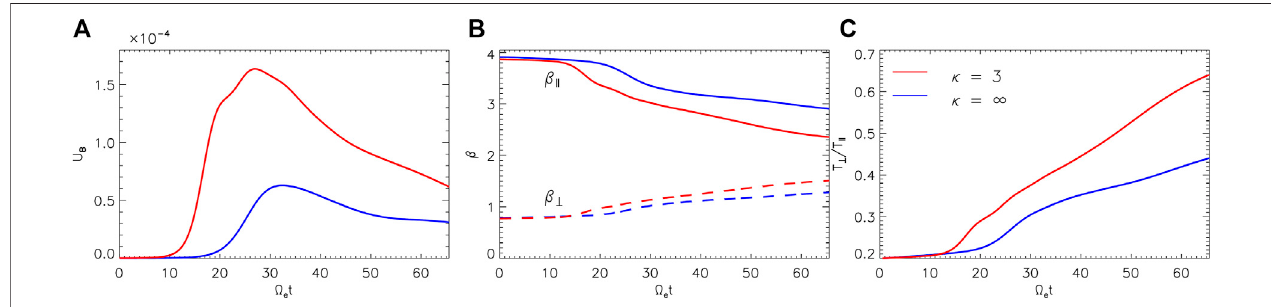
FIGURE4| TheresultsfromPICsimulationsoftheO-EFHinstabilityforbi-Kappa(red)andbi-Maxwellian(blue)electrons:temporalevolutionforthemagneticwave energy (A) , proton plasma beta components (B) , and the relaxation of temperature anisotropy (C) .